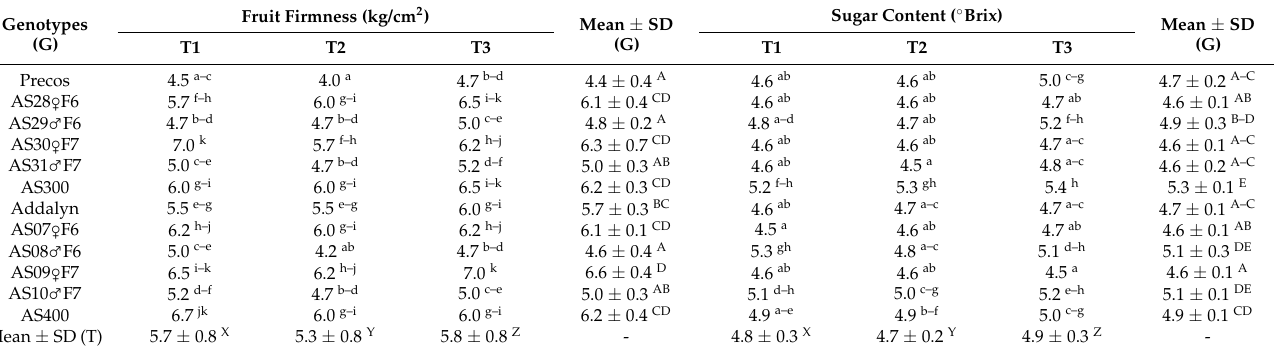
Table 7. Fruit firmness and sugar content of the fruits according to genotype and treatment.